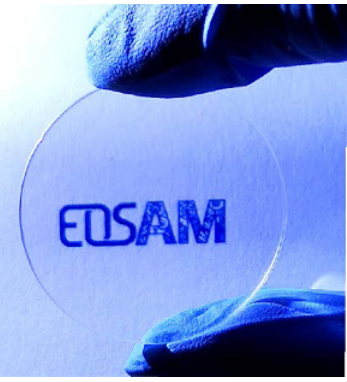
Fig. 11. Laser polishing of a biconvex lens made of Boroncrown glass